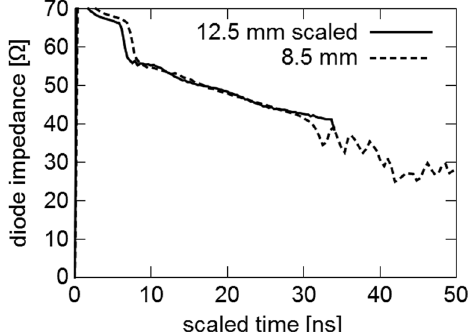
FIG. 16. The diode impedance from simulations of 8.5 and 12.5-mm diameter cathodes on a scaled time axis. (For the 12.5-mm cathode, t → 8 . 5 = 12 . 5 t .) The simulations include effects of expanding anode